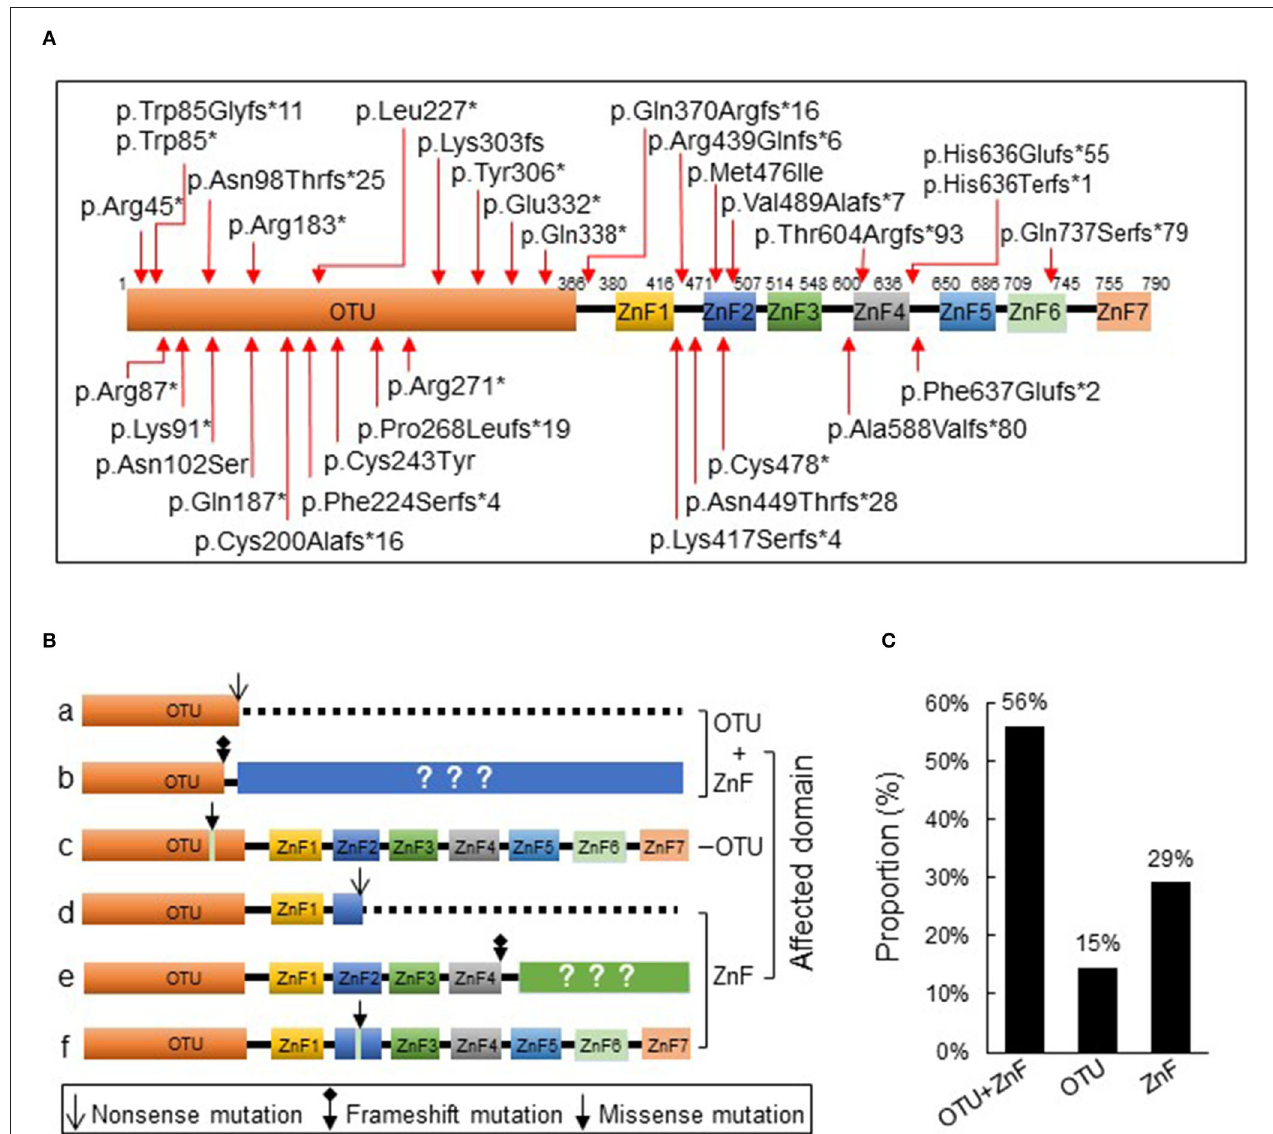
FIGURE 1 | Schematic diagram of A20 protein and its three types of disruption. (A) The protein A20 consists of an ovarian tumor (OTU) domain and seven zink-finger (ZnF) domains. The reported TNFAIP3 mutations from literature are indicated with arrow. (B) The reported TNAFIP3 mutations can result in three types of A20 disruption: disruption of both OTU and ZnF functional domains (a-b, OTU + ZnF), disruption of single functional domain OTU (c, OTU) or ZnF (d-f, ZnF). (C) The proportion of patients in each group. Patients were classified into the OTU + ZnF group, the OTU group and the ZnF group according to three types of A20 disruption. symptom was oral ulcers (70%), followed by recurrent fever (42%), gastrointestinal ulcers (40%), skin lesions (38%), genital ulcers (36%), musculoskeletal disorders (34%), and autoimmune thyroid disorder (19%). Less than 10% of HA20 patients presented with ocular involvement (7%), vasculitis (6%), atrophic gastritis (3%), kidney injury (6%), liver injury (8%), recurrent respiratory tract infection (9%), interstitial lung disease (4%), or dental anomaly (4%) was. Additionally, while the majority of patients with interstitial lung disease were in the ZnF group, patients with specific symptoms were mainly distributed in the OTU + ZnF group ( Figure 2A